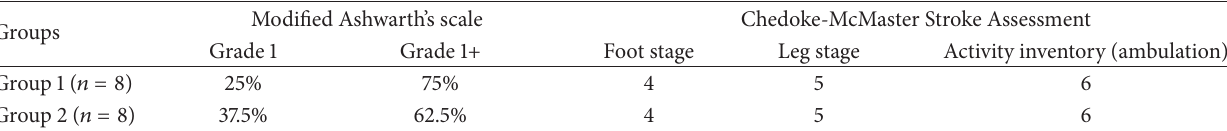
Table 2: Muscle tone assessment (percentage) and recovery and functional level.